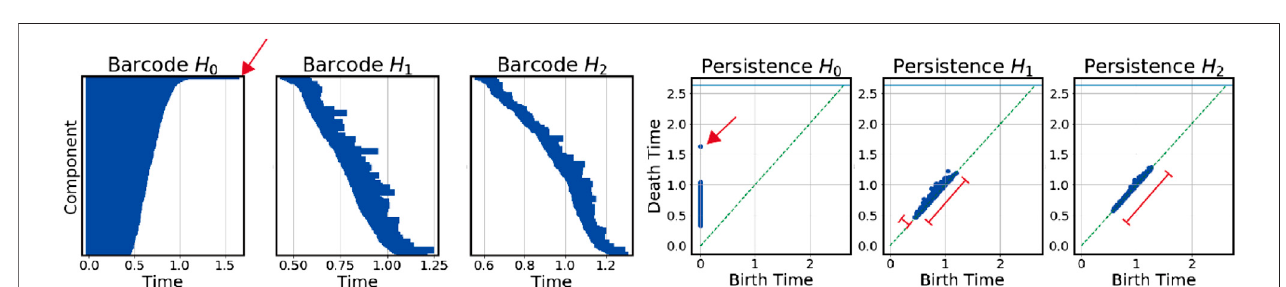
FIGURE 10 | The barcodes, and corresponding persistence diagrams for data collected from Apr 01, 2019 to Sep 30, 2019 in TAIEX.